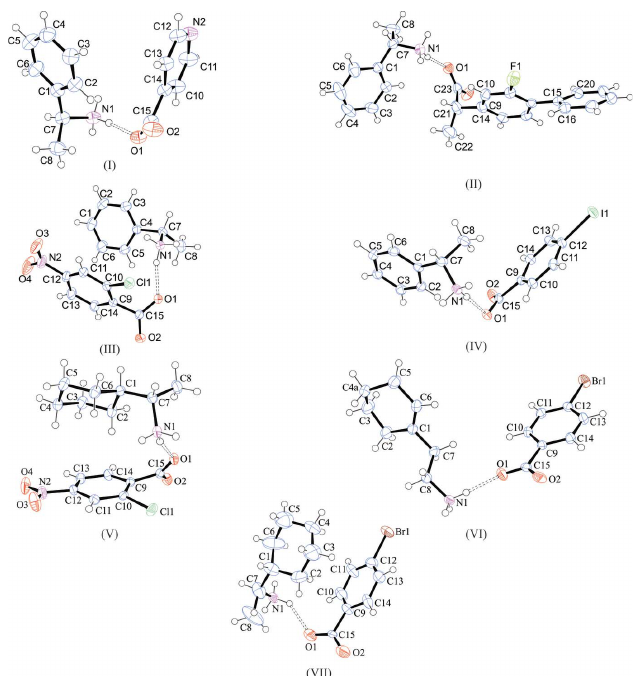
Figure 1 Perspective views of compounds (I)–(VII), showing the atom-numbering schemes. Displacement ellipsoids are drawn at the 50% probability level and H atoms are shown as small spheres of arbitrary radii. The dashed lines indicate the symmetry-independent N + —H (cid:2)(cid:2)(cid:2) O (cid:3) or N + —H (cid:2)(cid:2)(cid:2) N hydrogen